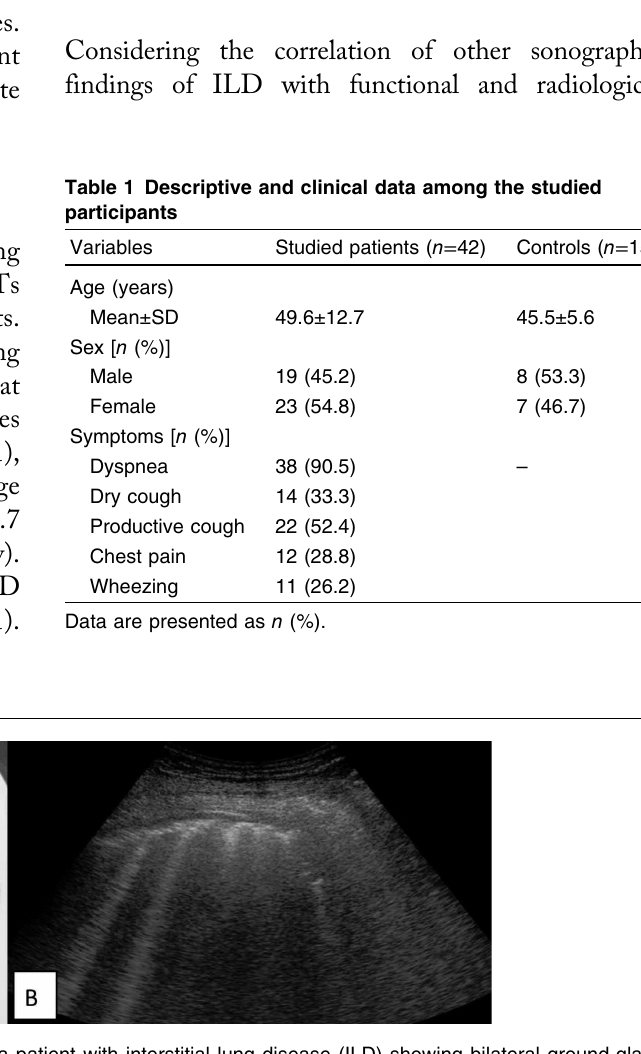
(a) Multidetector computed tomography (MDCT) of the chest in a patient with interstitial lung disease (ILD) showing bilateral ground-glass opacity. (b) Lung ultrasound of the same patient showing multiple B lines arising from a thickened and irregular pleural